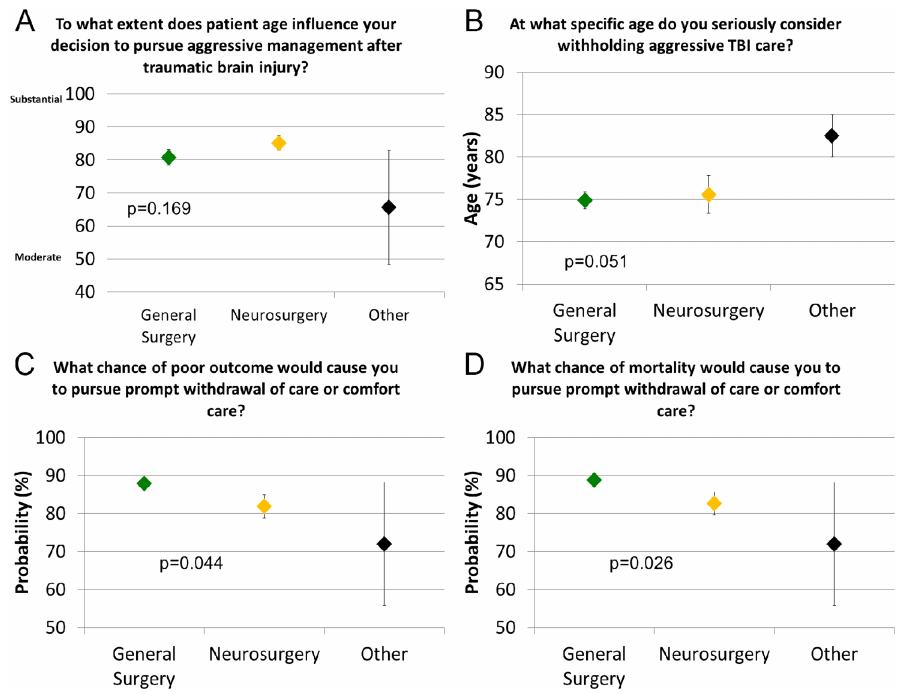
Fig 3. Responses to survey questions 18, 19, 17, and 16 (S1 Survey, Supplemental Digital Content 1) are presented in A, B, C, and D, respectively. In our survey, we posed a series of questionsthat assumed the calculatorproduced results that were 100% accurate. A) Reported extent to which age influences aggressivecare amongdifferent specialties, by specialty.Just over 10% of all respondents said that age